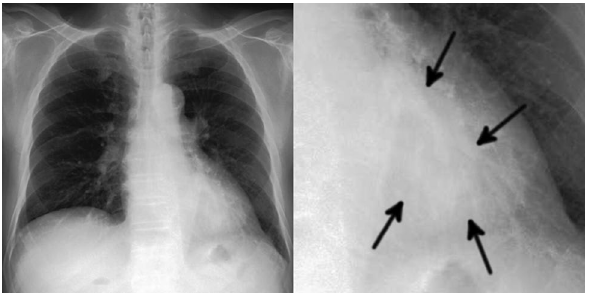
Figure 5. Example of one false negative case. The image on the left is a gross image, and the image on the right is an enlarged image of the lesion. A 68-year-old man with a mass in the left lower lobe that was diagnosed as adenocarcinoma. This lesion overlapped with the heart and is only faintly visible (arrows). Our model failed to detect the